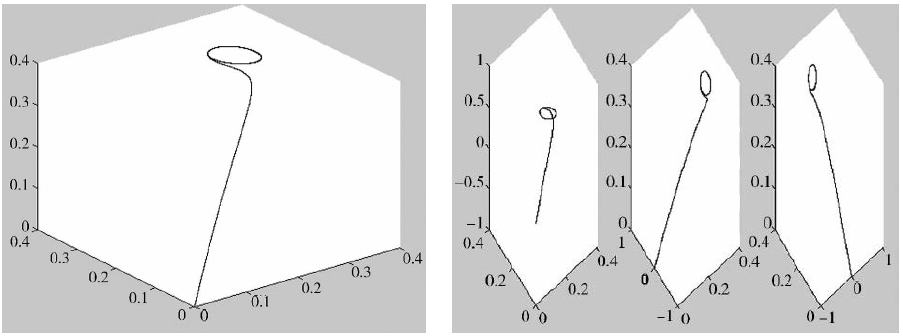
Fig. 8 Orbital diagram of parameter a = 0 and evolution time of 10000-unit time